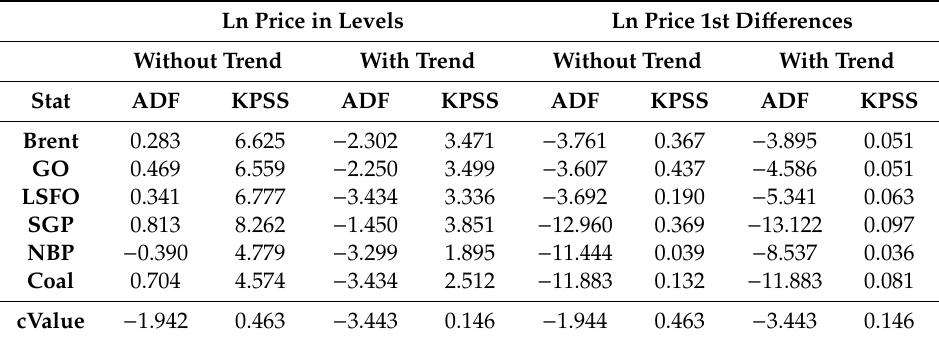
Table 2. Generic unit root tests